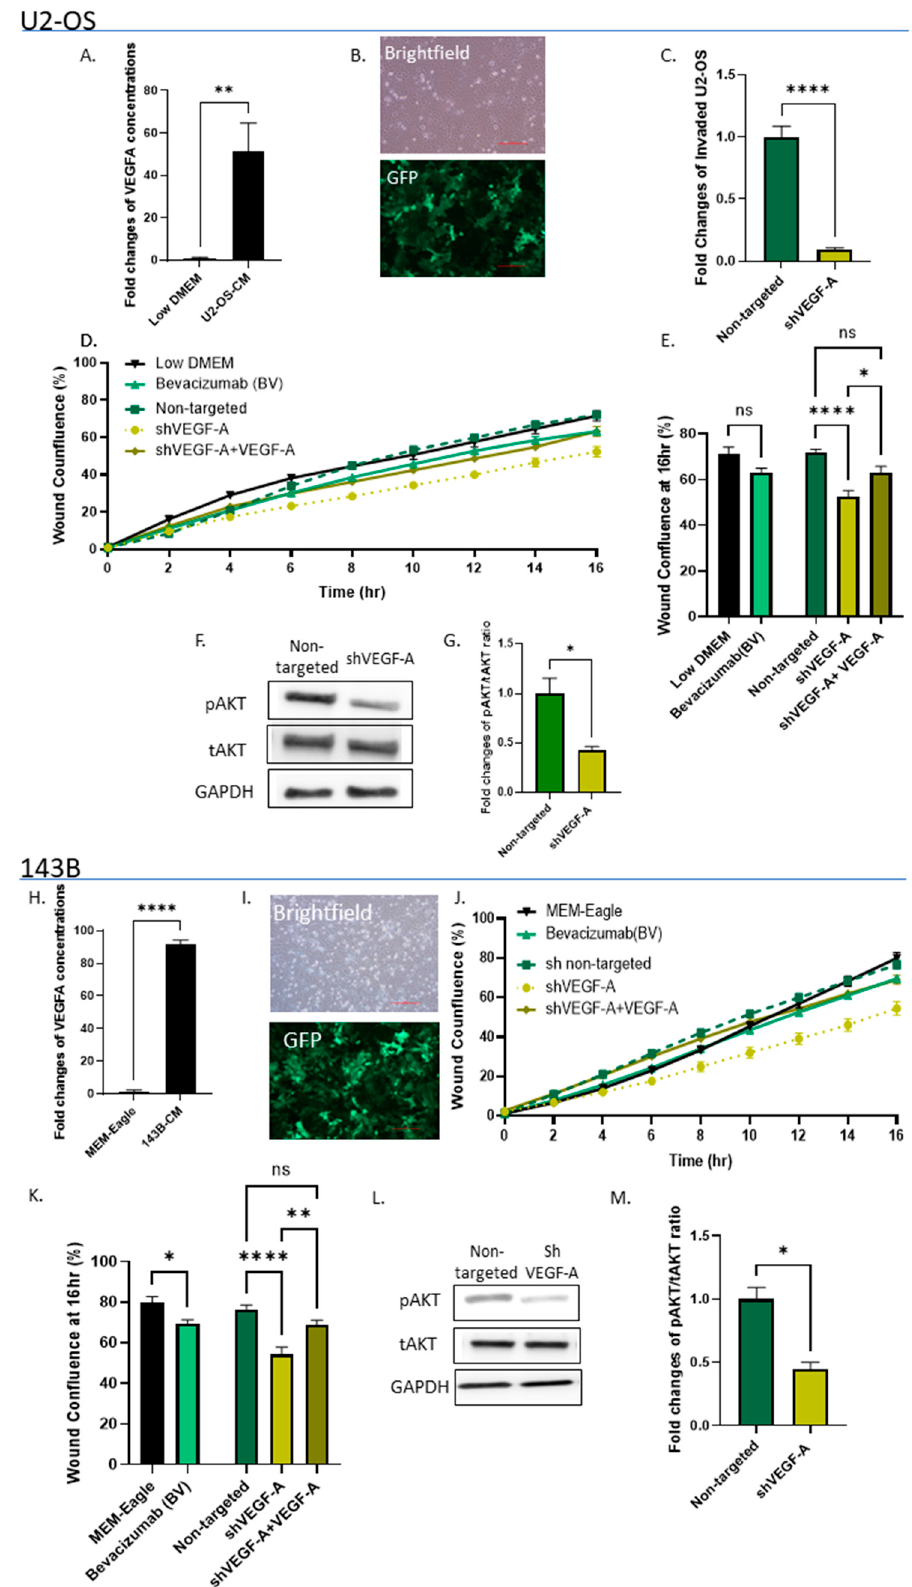
Figure 3. OS cells secrete VEGF-A, which promotes their invasiveness in an autocrine manner. ( A , H ) ELISA results reveal very high VEGF-A levels in U2-OS and 143B cell secretomes compared to standard growth media (Low DMEM/MEM-Eagle); ** p < 0.01, and **** p < 0.0001, respectively. ( B , I )